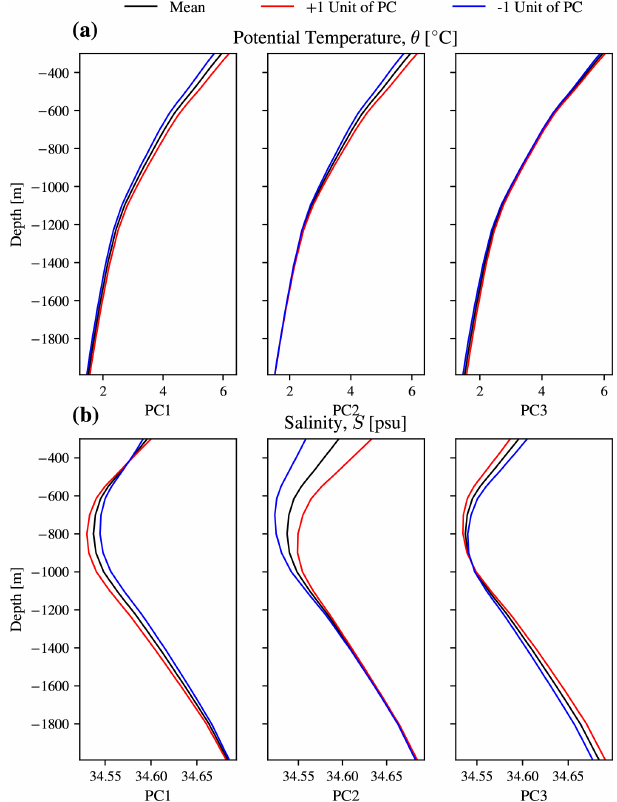
Figure B2. The temperature and salinity components of the three retained principal components that were used in this work. Specif- ically, they are PC1 (left column), PC2 (middle column), and PC3 (right column). Shown are the mean structures (black lines) with the effect of adding (red line) or removing (blue line) one unit of a prin- cipal component as a deviation from the mean profile, after Fig. 4 in Pauthenet et al. (2017). When compared to Fig. 1 we can see that PC1 corresponds to the hot–cold north–south